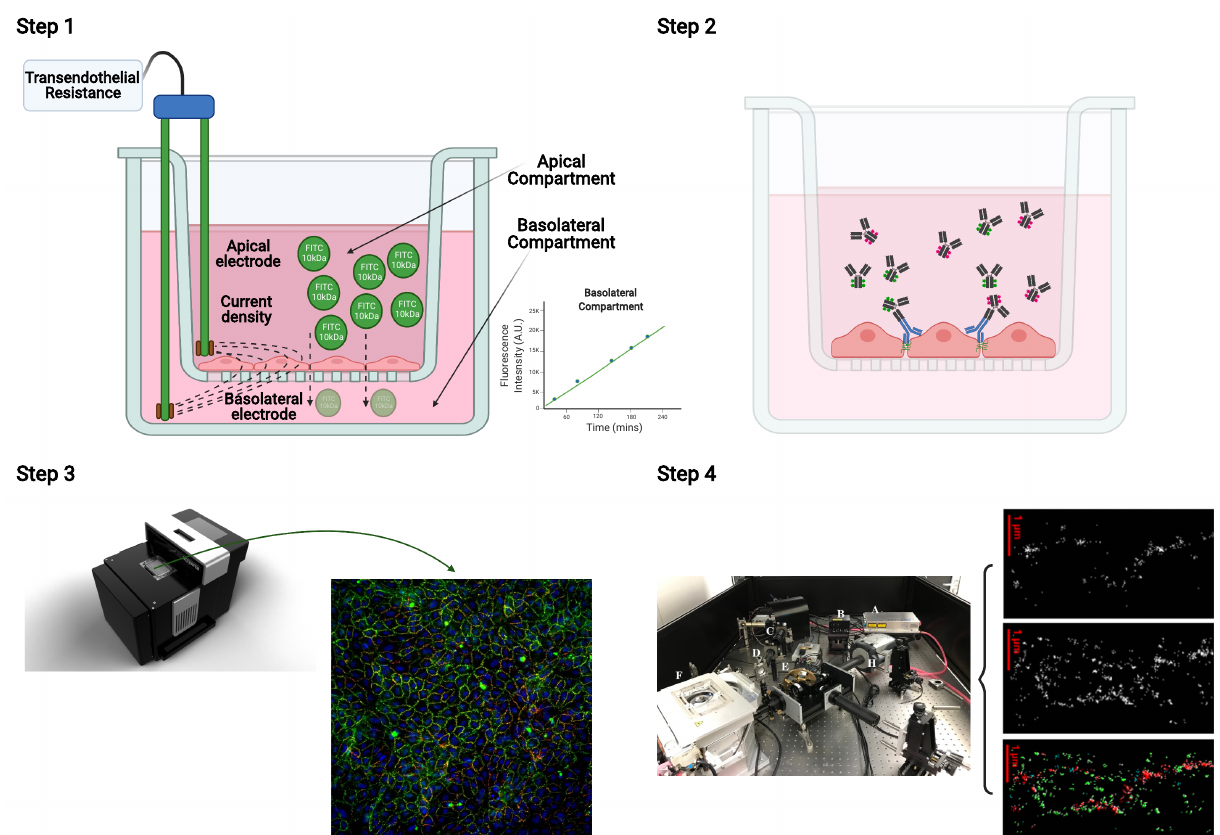
Figure 6. Integration of the stepwise experimental workflow for in-depth TJ study in endothelial cells. HUVECs were grown on PC Transwell filters, and the transendothelial resistance (TER) of the monolayer was measured with a volt/ohm meter until confluence. ( Step 1 ): After confluent monolayer formation, experimental solutions were added and TER changes along with 10kDa FITC dextran paracellular transport were monitored for a 4-hour period. ( Step 2 ): Subsequent immunofluorescent staining was performed on the monolayer in the PC Transwell filter with different fluorescently labeled antibodies. ( Step 3 ): Automated immunofluorescence intensity analysis was performed from a z-stack by the ACQUIFER Imaging Machine comprising 10% of the entire insert. ( Step 4 ): The same filter was subjected to single molecule localization microscopy (SMLM) followed by image processing of the junction area. Image processing algorithms were employed in order to assess the clustering of the TJ proteins of interest. The Figure was constructed with BioRender.com (accessed on 17 March